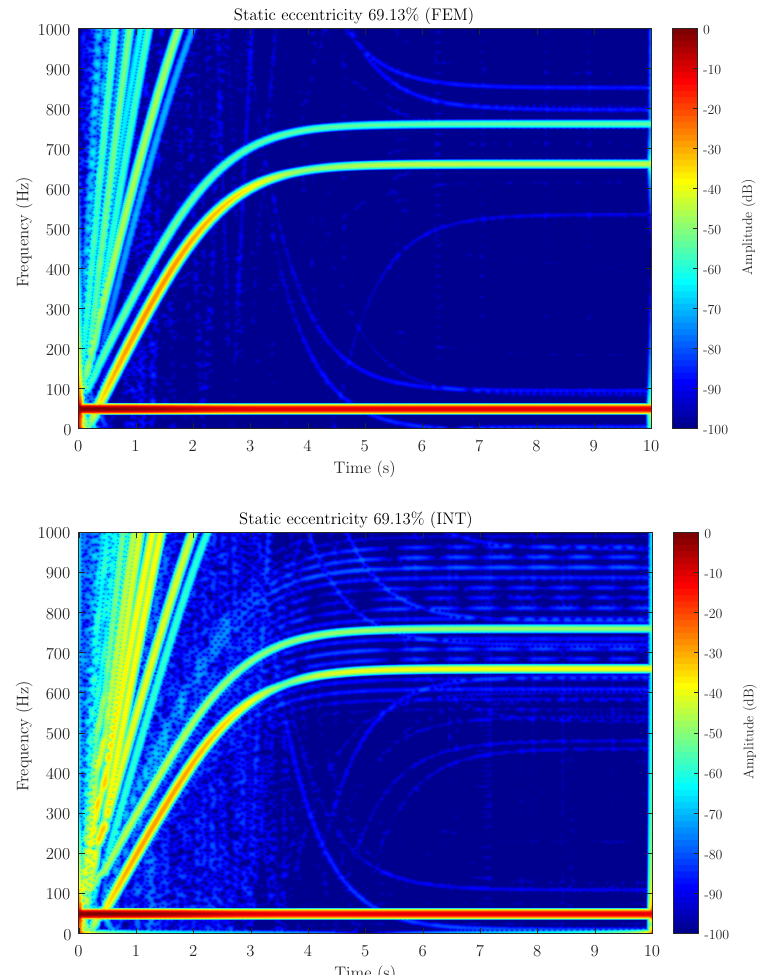
Figure 8. Stator current spectrogram for static eccentricity level 69.13% using FEM software (FEM) and the proposed method (INT) to calculate the coupling parameters of the hybrid FEM-analytical model. The hybrid model obtains a good approximation of the amplitude for detecting the presence of the